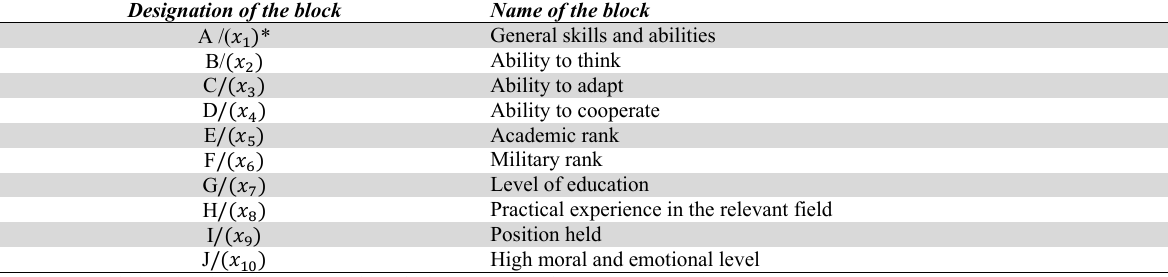
Practical experience in the relevant field